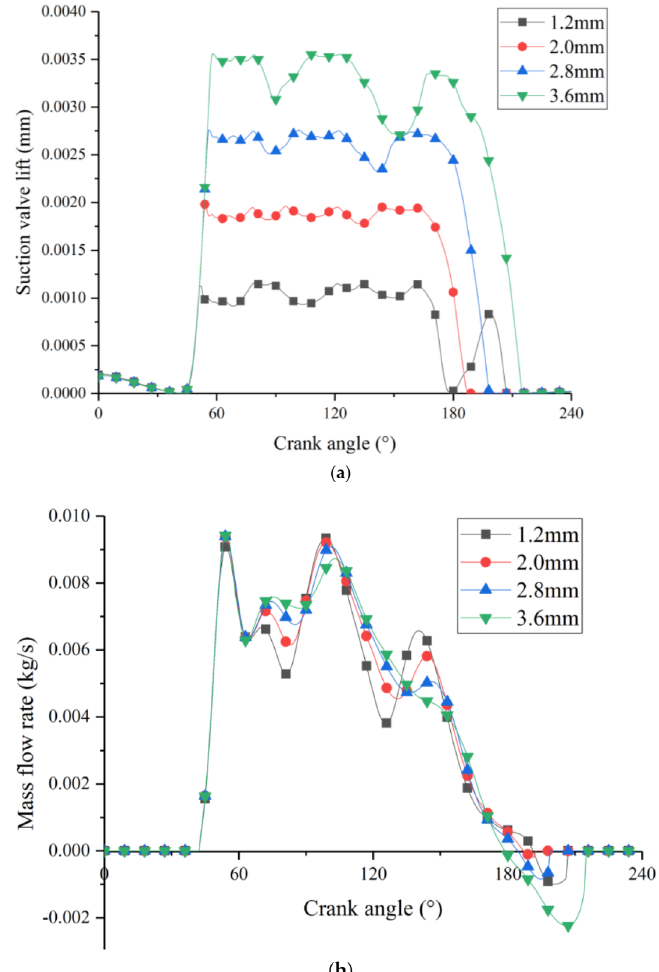
Figure 18. ( a ) The movement of the suction valve at various limiter heights. ( b ) The mass flow characteristics of the suction valve at various limiter